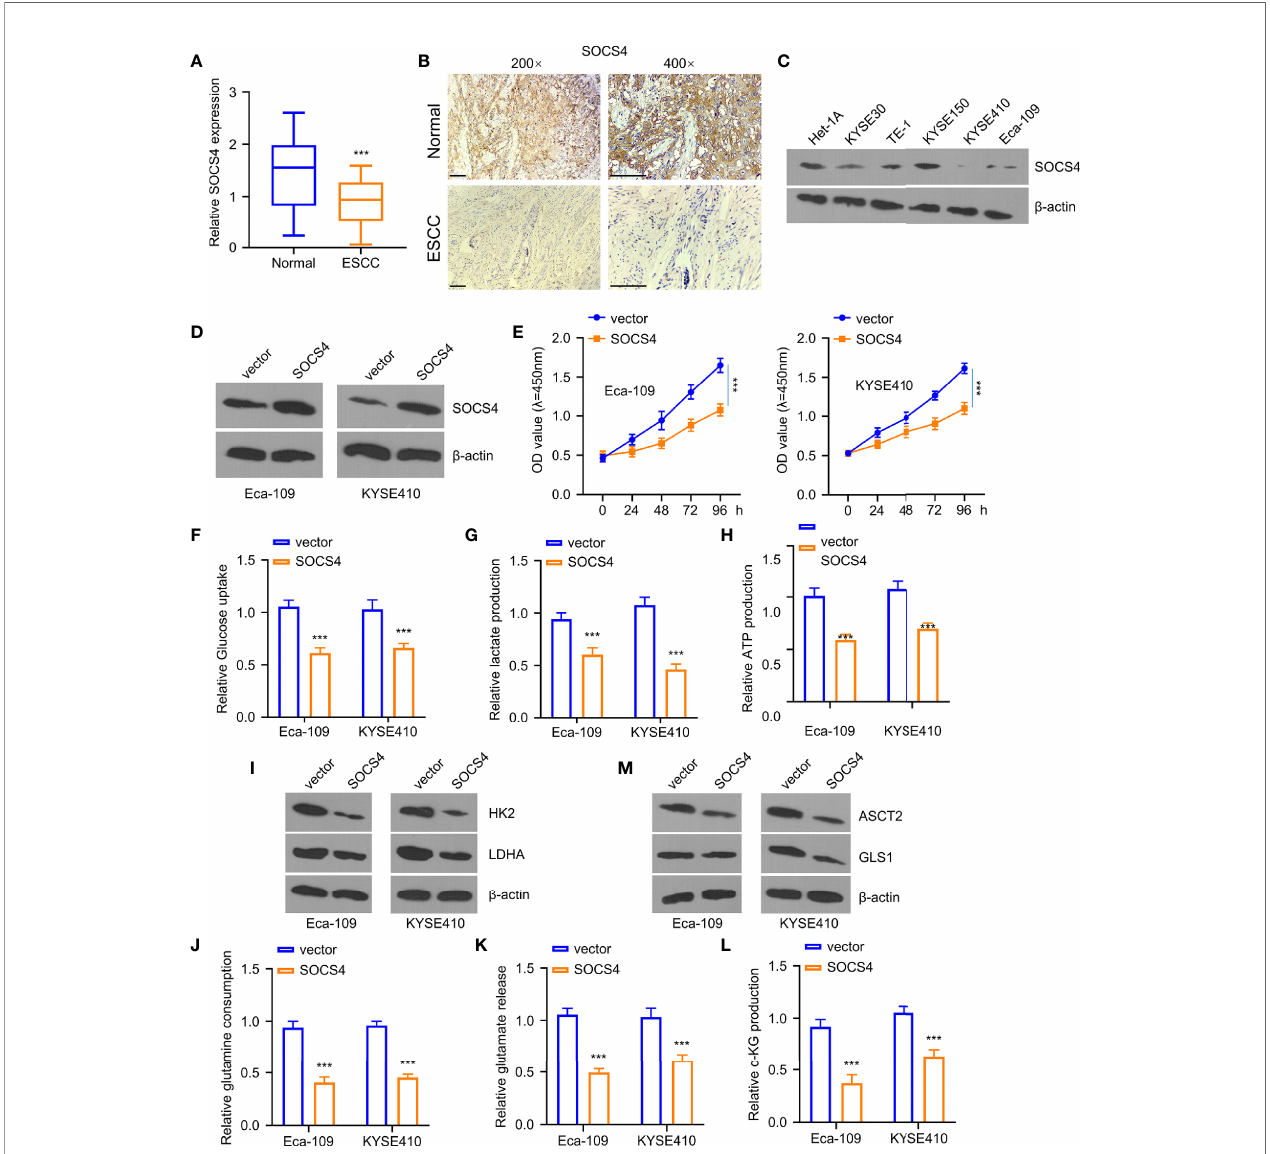
FIGURE 6 | Overexpression of SOCS4 inhibited glycolysis and glutamine decomposition of esophageal squamous cell carcinoma (ESCC) cells. Western blotting (WB) (A) and immunohistochemistry (B) were used for determining SOCS4 expression within 80 ESCC and matched non-carcinoma samples. (C) SOCS4 protein levels within ESCC cells and healthy cells (het-1a) and (D) the overexpression of SOCS4 ef fi ciency were detected by the WB method. (E) The cell viability of Eca-109 and KYSE410 cells at 0, 24, 48, 72, and 96 h was detected by the CCK-8 kit. (F – H) The glucose consumption, lactate production, and ATP in different groups (vector, SOCS4) of Eca109 and KYSE410 cells were de fi ned by the glycolysis kit. (I) The levels of hK2 and ldhA protein in different groups (vector, SOCS4) of Eca- 109 and KYSE410 cells and (M) gls1 and ASCT2 protein levels within cells with or without SOCS4 transfection. (J – L) Glutamate, glutamine, and a -KG expression in cells transfected with/without SOCS4 transfection was detected by a -KG detection kit. * P < 0.05, ** P < 0.01, and *** P <